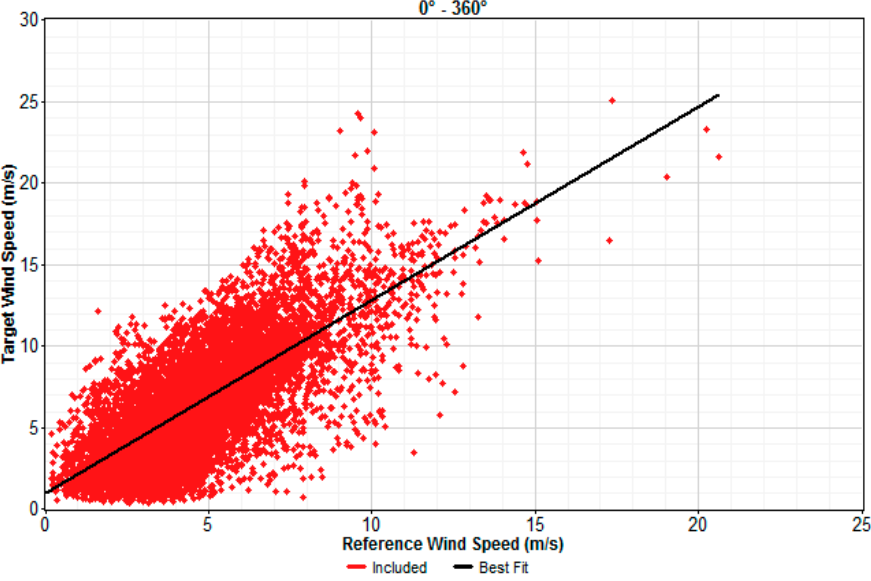
Figure 10. Correlation between the target and reference wind speeds.